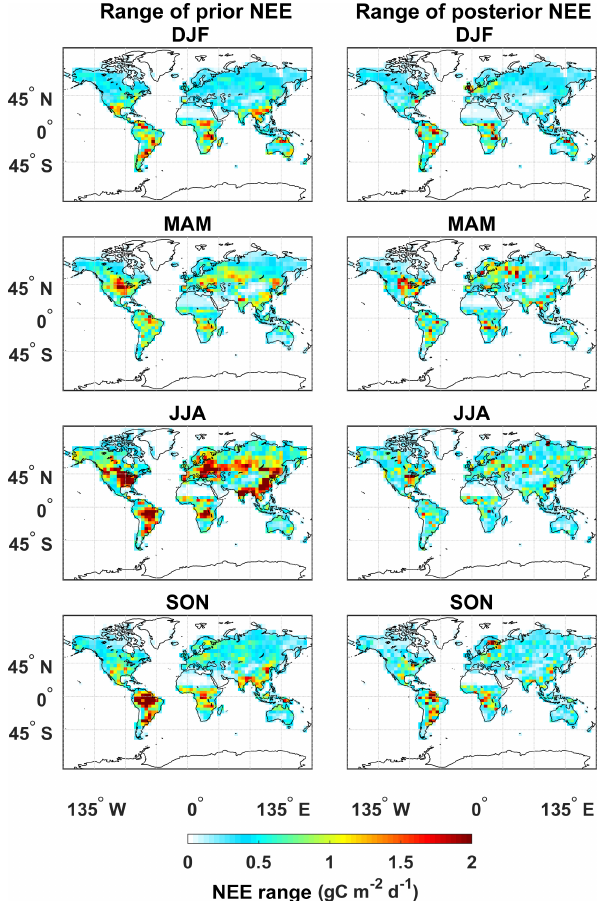
Figure 2. Prior multi-model (NASA-CASA, CASA-GFED, SiB-4, and LPJ biosphere models) seasonally averaged NEE (gCm − 2 d − 1 ; left column) and NEE SD (standard deviation) (gCm − 2 d − 1 ; right column) for the year 2015.